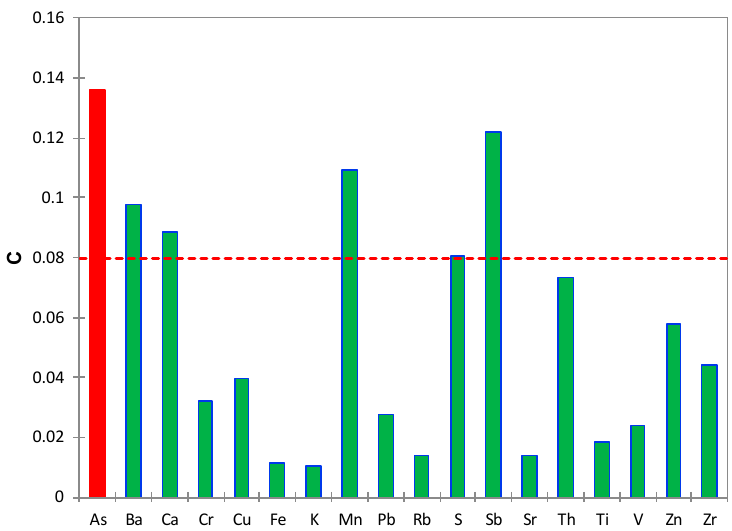
Figure 9. Cochran’s C test. Samples from Ah horizon, pXRF raw data. Table 4. Contribution of each element to the six main factors for Ah horizon, clr pXRF measurements.